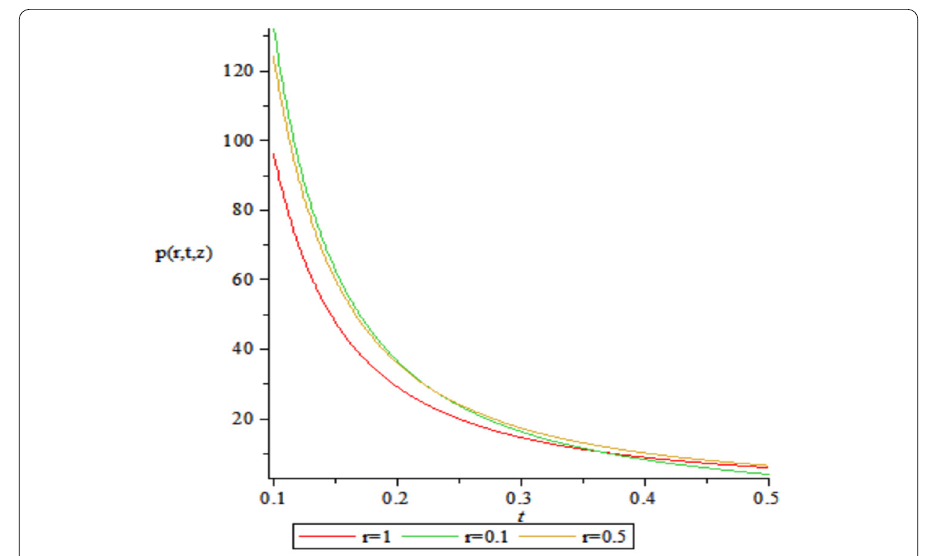
Figure 12 The pressure p ( r , t , z ) at z = 1, c 1 = 1, and c 4 =